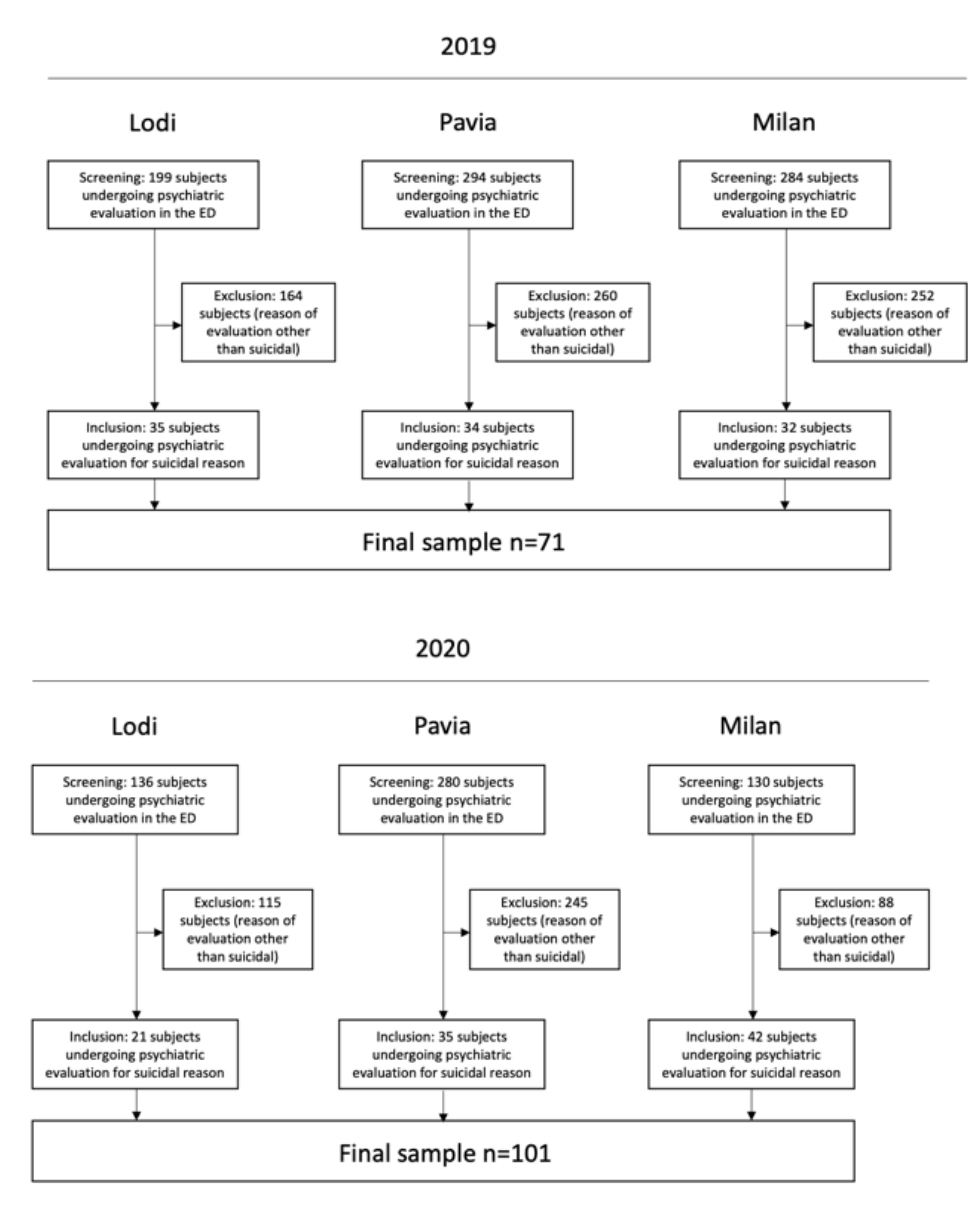
Figure 1. Recruitment Flow-chart.